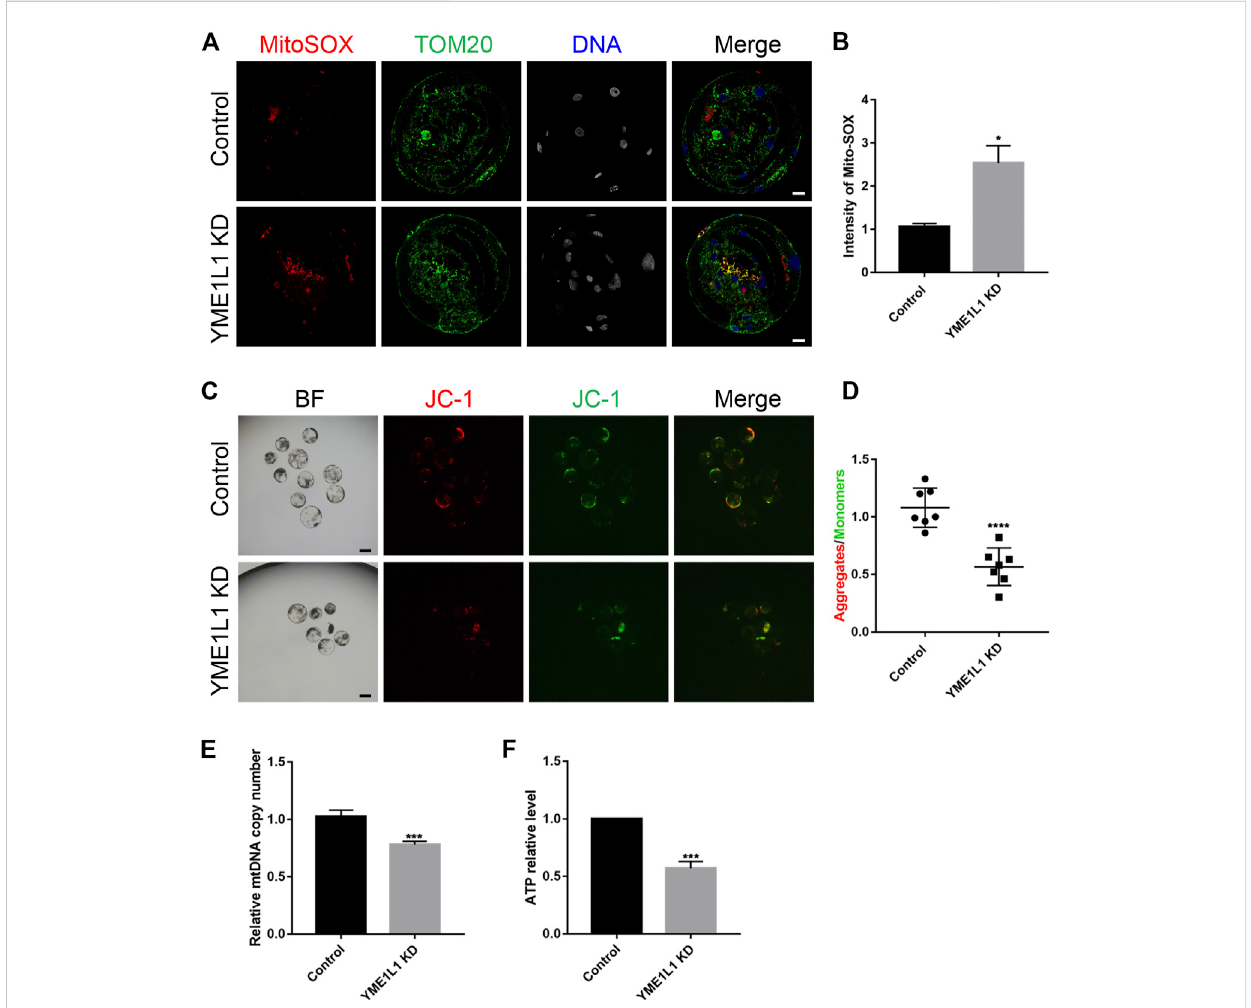
FIGURE 4 Knock-down of YME1L1 stimulates production of ROS and depolarizes mitochondrial membrane potential during embryo development. (A, B) Representative confocal images of Control and YME1L1 KD blastocysts showing MitoSOX and TOM20 staining and mitochondrial ROS levels. (C, D) JC-1 staining of blastocyst stage embryos in control and YME1L1 KD group. (E) Quantitative PCR con fi rmed relative copy numbers of mtDNA in control and YME1L1 KD group. (F) ATP levels at blastocyst stage in control and YME1L1 KD group. Scale bars, 20 μ m * p < 0.05, *** p < 0.005, and **** p < 0.001 were considered as signi fi cant